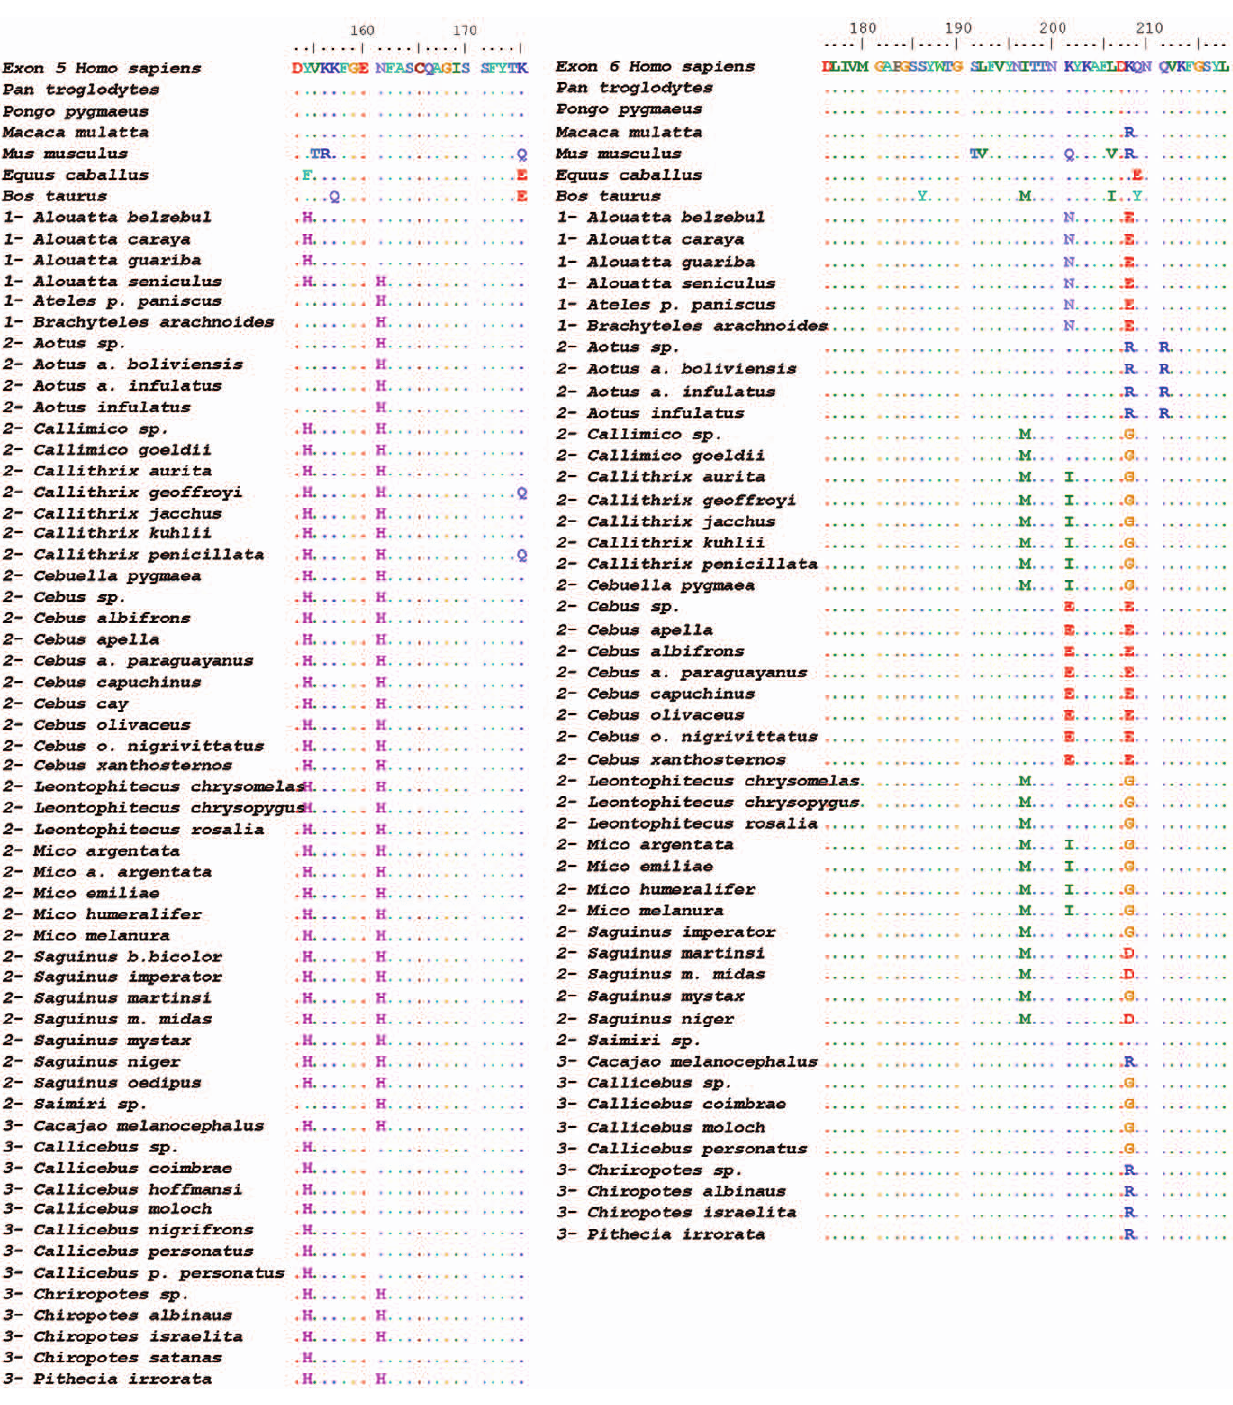
Figure 2. Amino acid alignment of the predicted sequences encoded by ITGA4 exons 5 (left) and 6 (right) of representative species of neotropical primates. Sequences of each species represent a consensus from 2-19 individual specimens sequenced in this study. Residue numbering corresponds to that of the mature a 4 subunit protein, after cleavage of the signal peptide. Dots represent identities. Numbers before species’ names depict Platyrrhini families as follows: 1- Atelidae; 2- Cebidae; 3- Pitheciidae (as proposed by Schneider et al . [38]). For means of comparison, ITGA4 sequences from human ( Homo sapiens ), chimpanzee ( Pan troglodytes ), rhesus macaque ( Macaca mulatta ), mouse ( Mus musculus ), horse ( Equus caballus ), cow ( Bos taurus ) and African green monkey ( Chlorocebus sp .) are shown at the top of the alignment. doi:10.1371/journal.pone.0024461.g002 tested. These included mutants with changes of the original lysine We have observed varying effects of the a 4 polymorphisms residue found in humans to an isoleucine, an asparagine or a when assessing binding of different ligands, such as monoclonal antibodies, natural ligands (VCAM and MAdCAM) and HIV-1 glutamic acid, found in distinct NWP genera.